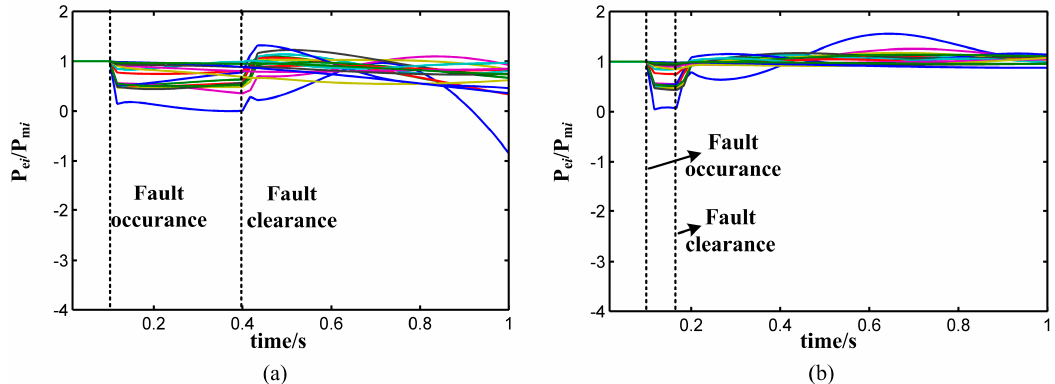
Figure 2. The variation of P e i / P m i of 16 ‐ machine 68 ‐ bus system: ( a ) unstable case; and ( b ) stable case.